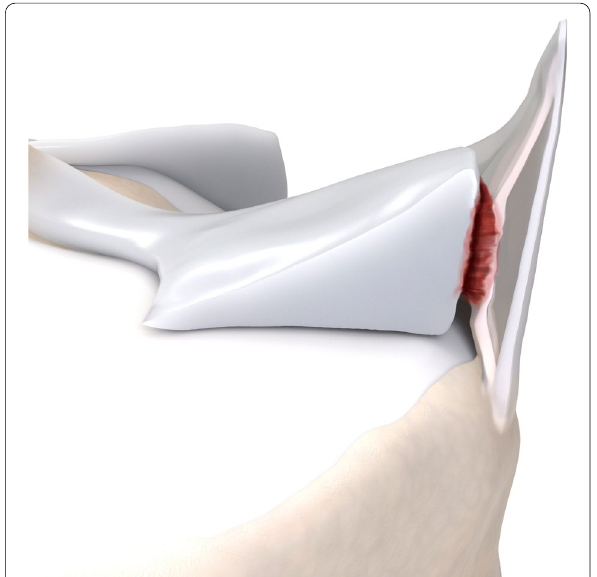
Fig. 14 Type 5 meniscal ramp lesion illustration, defined as peripheral posterior horn meniscal double